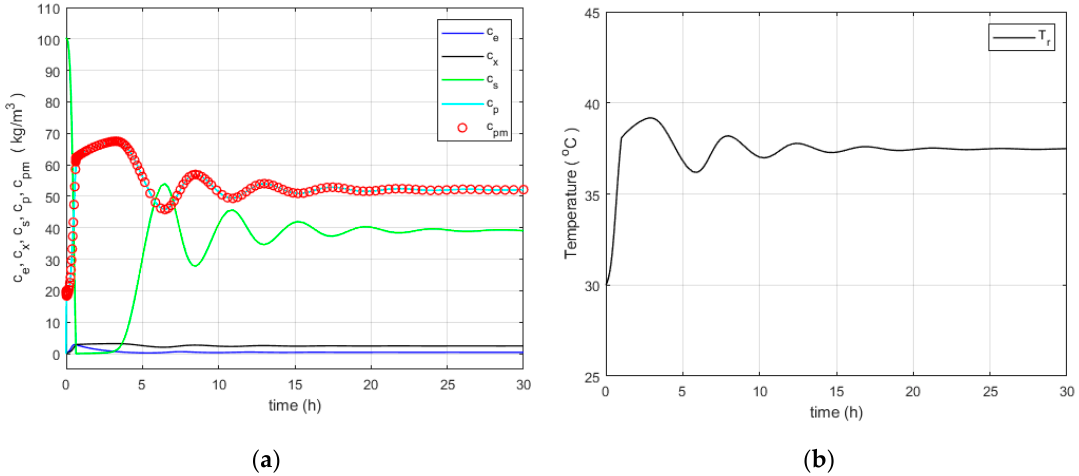
Figure 4. Process open-loop simulation dynamics: ( a ) concentration profiles of different components and ( b ) reactor temperature profile.